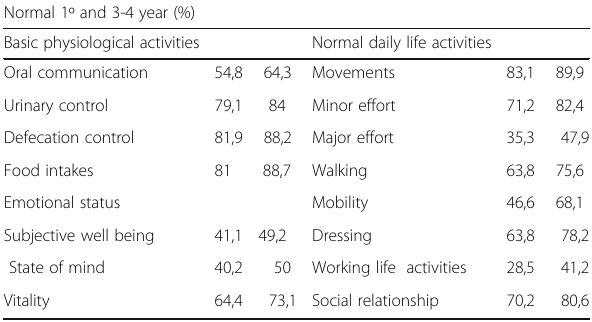
Table 1 (abstract 000262). See text for